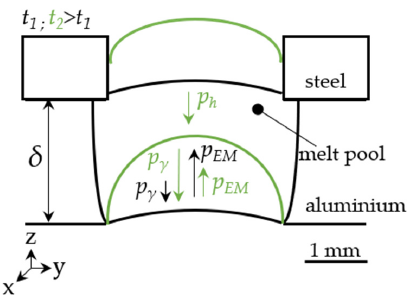
Figure 3. The development of the pressures at the aluminium alloy melt pool during displacement.